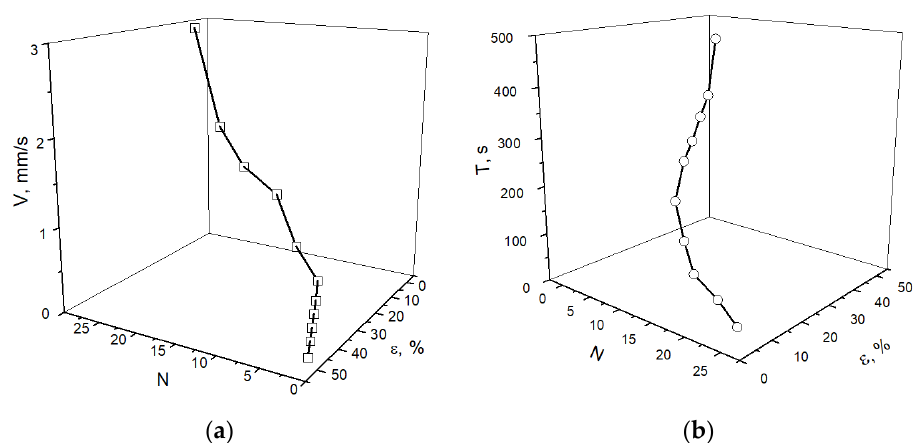
Figure 4. Propagation velocity V ( a ) and time period T ( b ) of PLC bands vs. the number of bands N and the total deformation of the polycrystalline Ni in the load–unload mode.